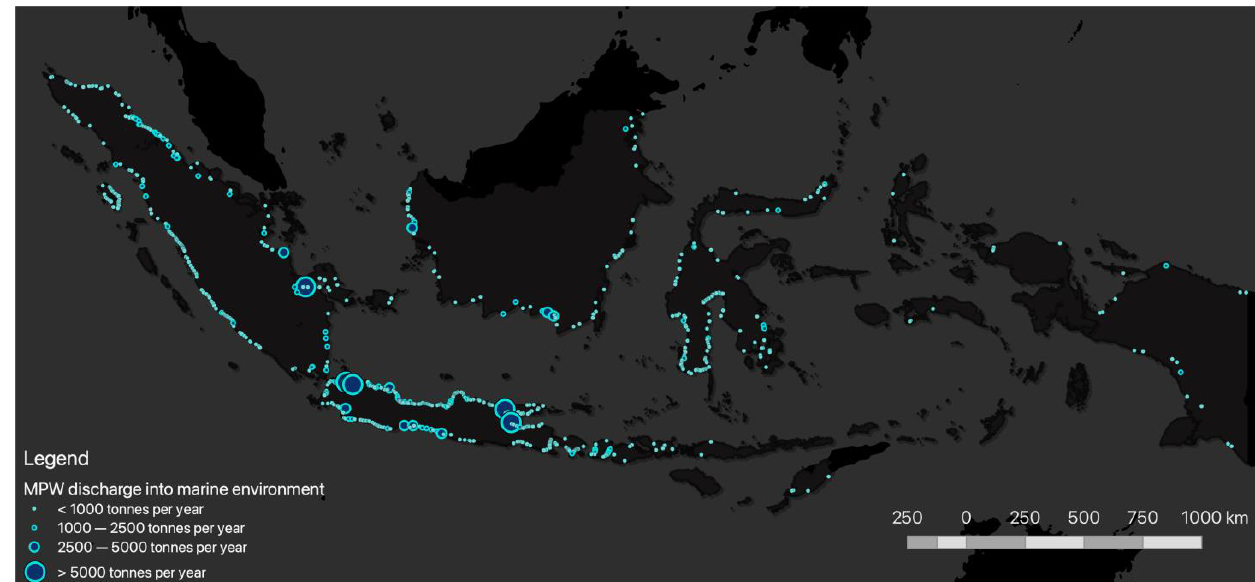
Figure 3. Estimated annual discharges of plastic waste from rivers and coastlines in Indonesia.